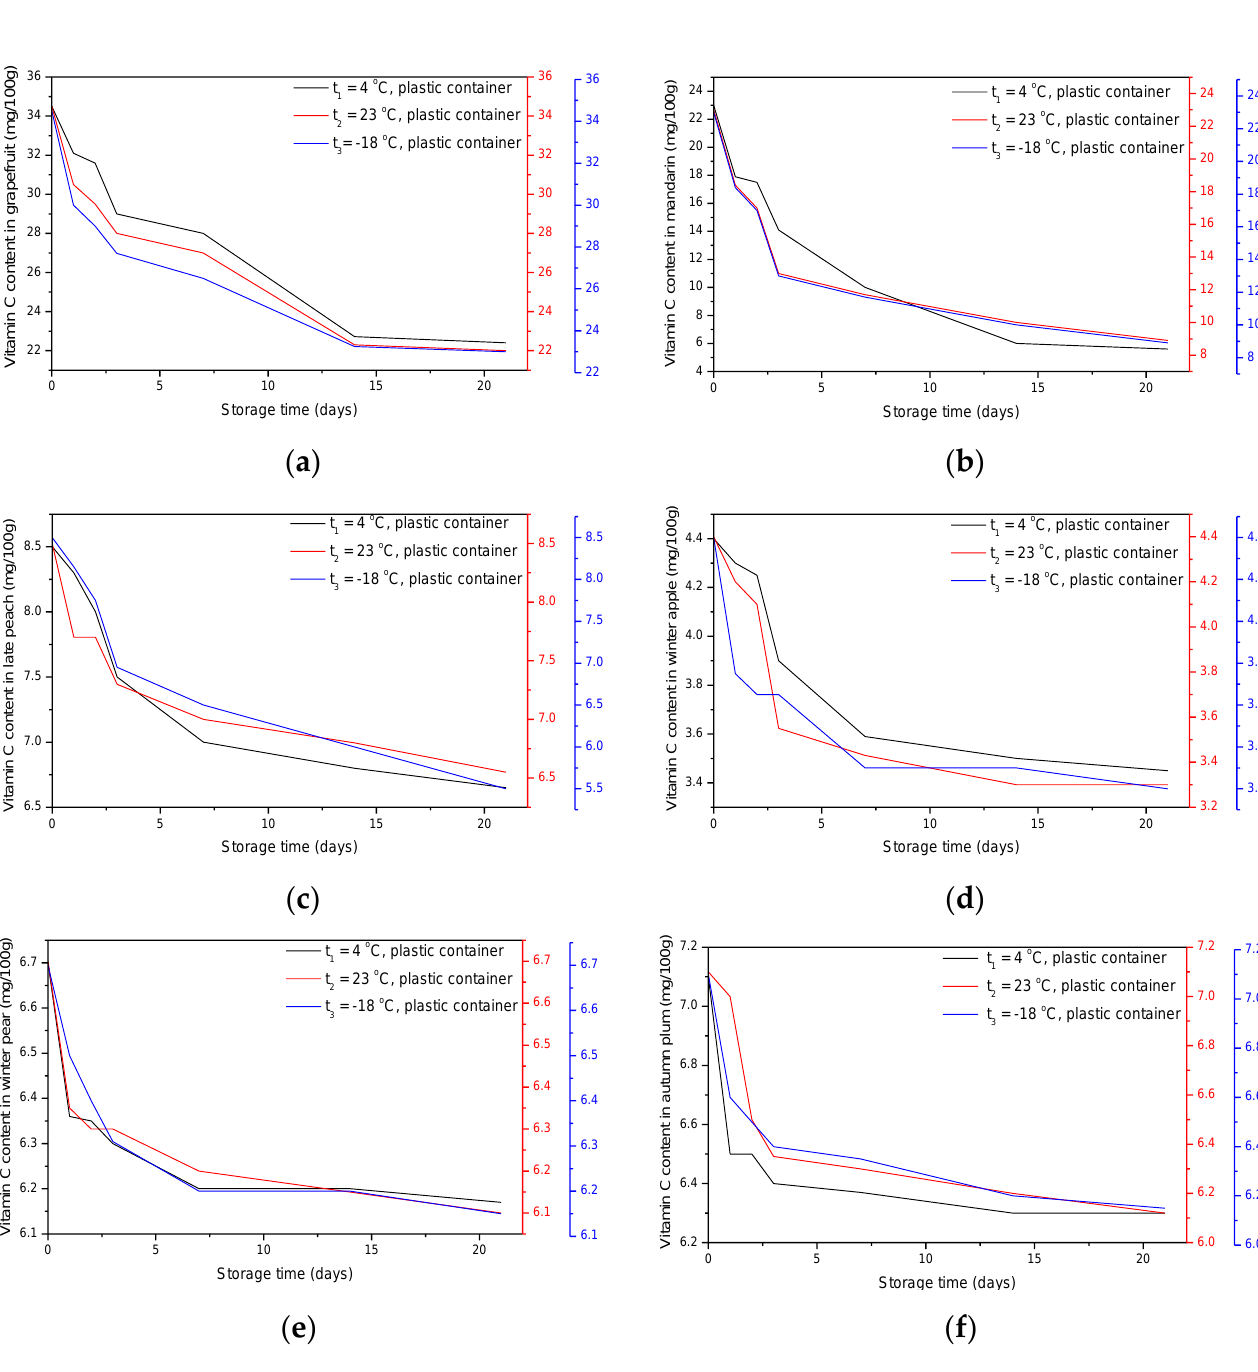
Figure 4. The vitamin C content in fruit juices in different temperatures in plastic containers: ( a ) grapefruit, ( b ) mandarin-clementine, ( c ) late peach, ( d ) winter apple, ( e ) winter pear, ( f ) autumn plum.